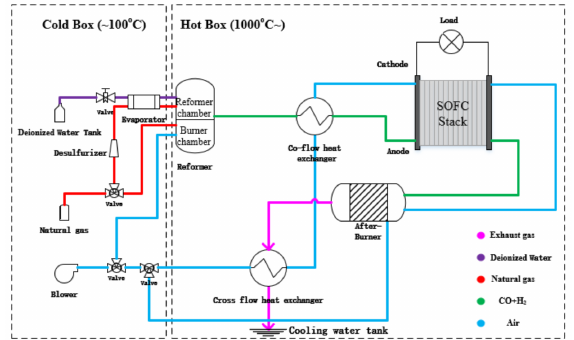
Figure 1. Architecture diagram of natural gas SOFC system.